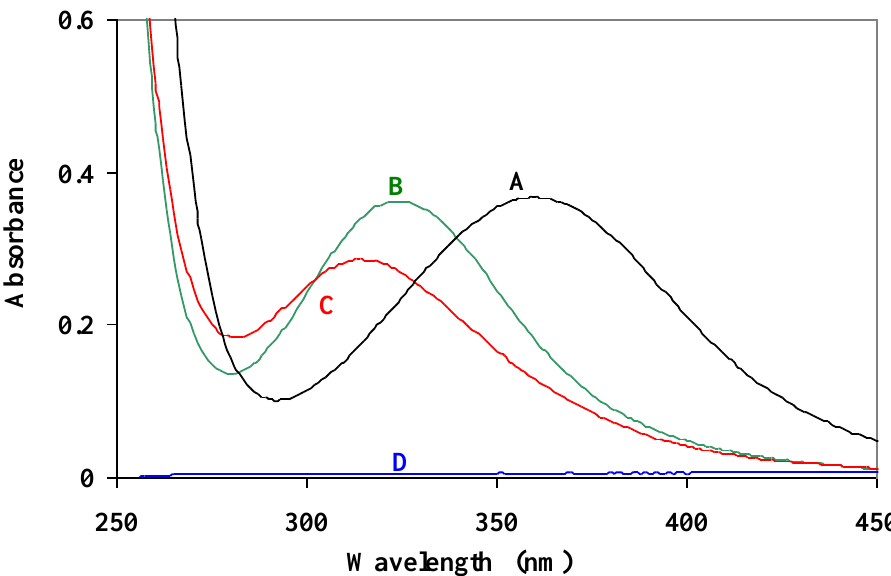
Figure 4. The electronic absorption spectra of the [Pd(AEMP)(H 2 O) 2 ] 2+ - glycylglycine system: (A) 1 × 10 − 3 M [Pd(AEMP)(H 2 O) 2 ] 2+ ; (B) 1 × 10 − 3 M [Pd(AEMP)(H 2 O) 2 ] 2+ and 1 × 10 − 3 M glycyl- glycine + 1 × 10 − 3 M NaOH; (C) 1 × 10 − 3 M [Pd(AEMP)(H 2 O) 2 ] 2+ , 1 × 10 − 3 M glycylglycine and 2 × 10 − 3 M NaOH, (D) 1 × 10 − 3 M glycylglycine. The ionic strength was 0.10 M NaNO 3